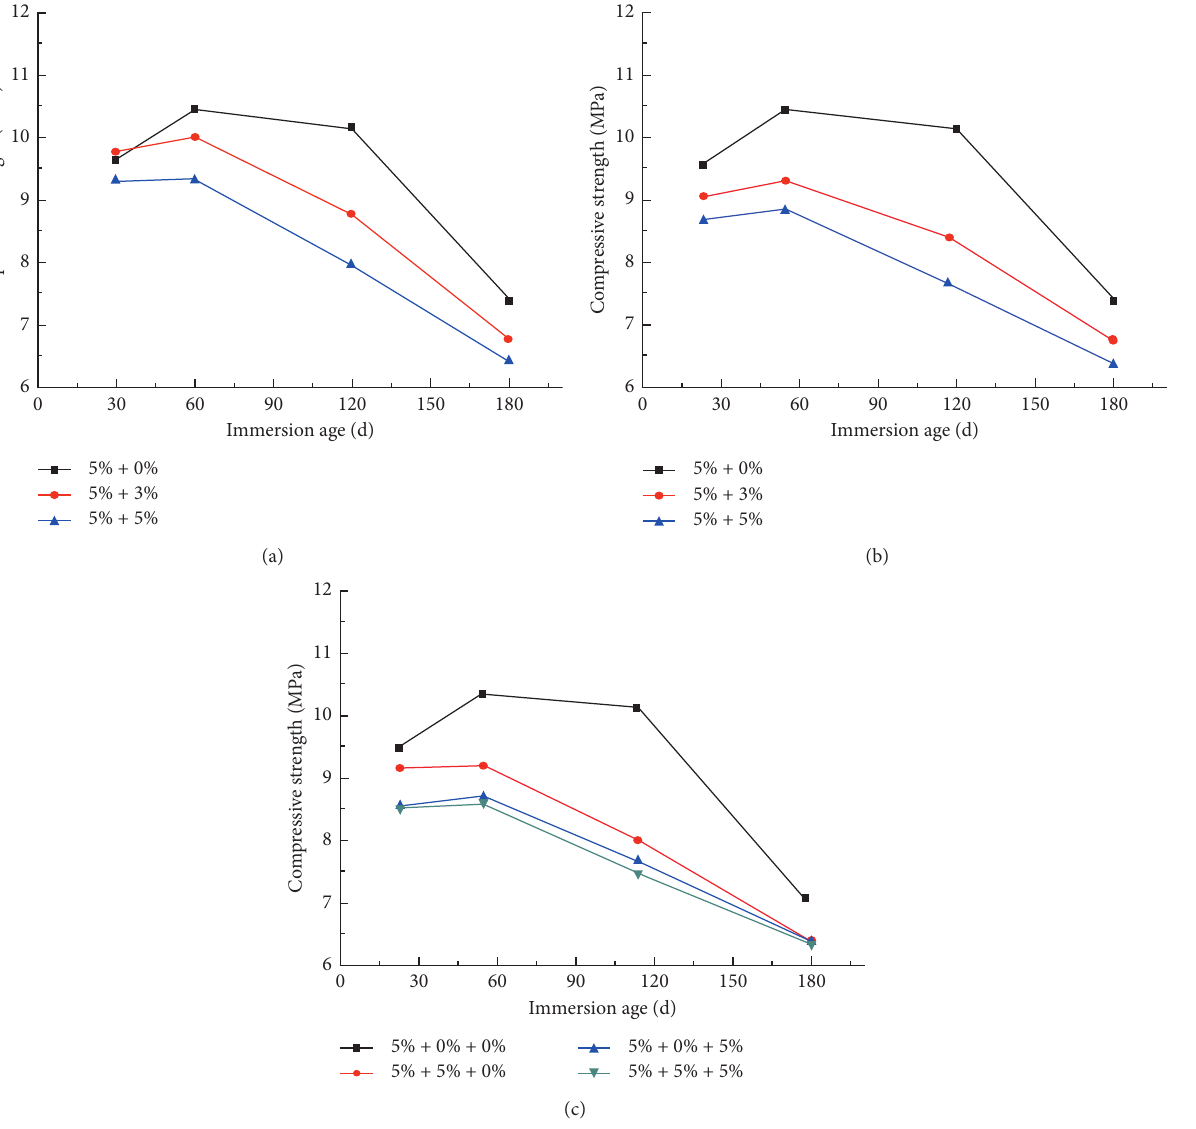
2 SO 4 +MgSO 4 , (b) Na 2 SO 4 +NaHCO 3 , and (c)